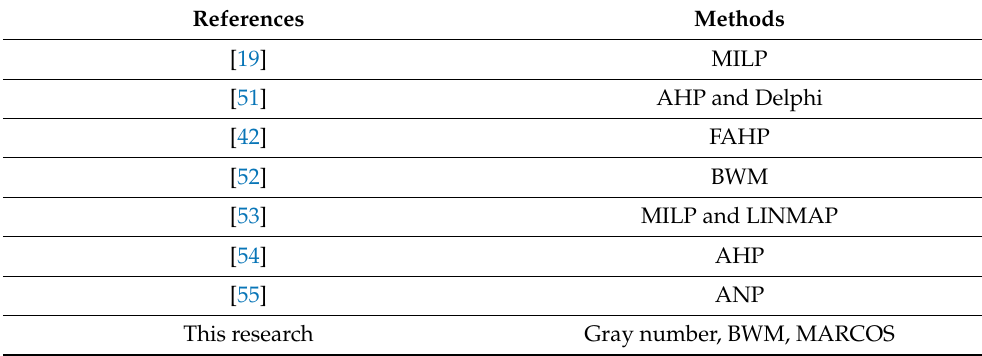
Table 2. Methods of contract SCM